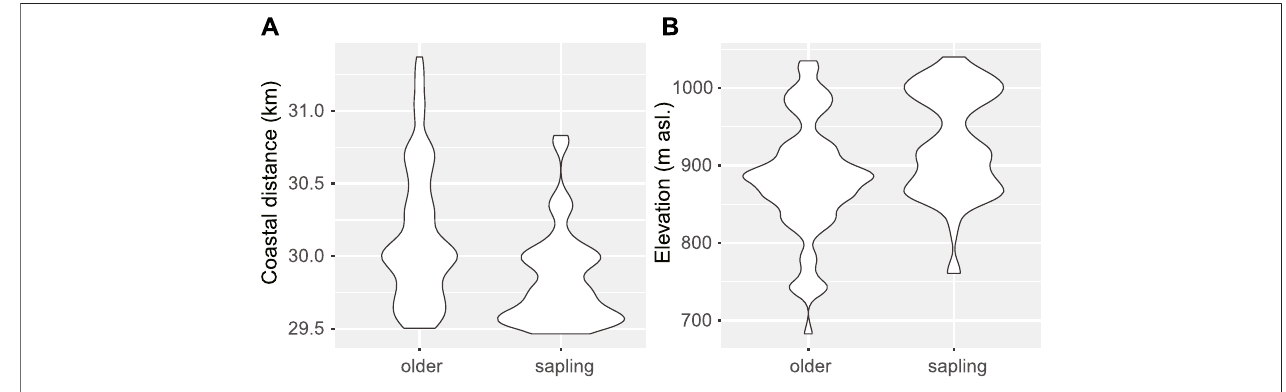
FIGURE6 | DensitydistributionofolderandsaplingTombatobservationsaccordingto (A) Coastaldistanceand (B) Elevation.Adjustparameterwassetto0.5(ggplot2).